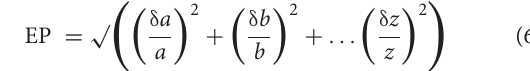
Frontiers in Marine Science |